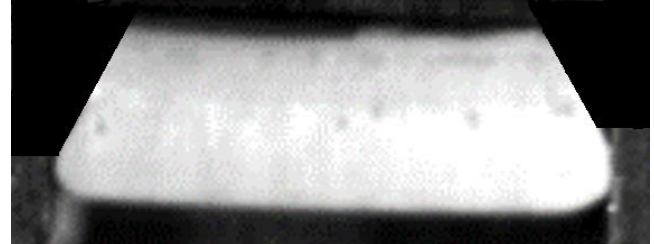
Figure 5. Simulated ideal slug after rupture.